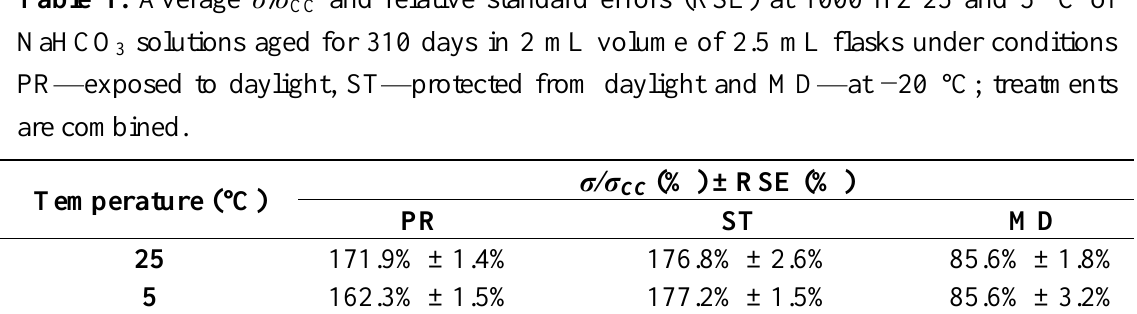
of one day old (CC) and NaHCO3